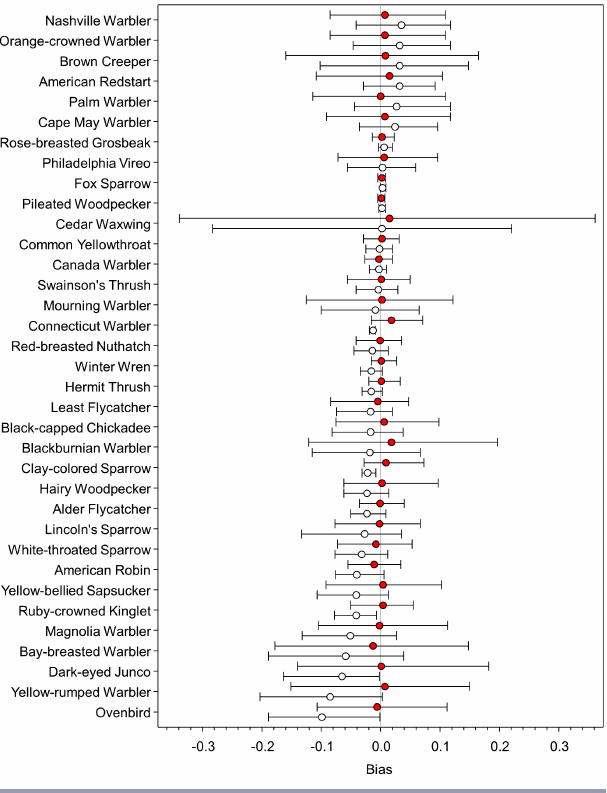
Fig. 4 . Bias in estimated densities (birds ha -1 ) from point count data derived from autonomous recording units (ARUs) compared to densities derived from human point counts conducted at the same time and location. Densities from human point counts were derived by adjusting counts for biases in availability ( p ) and perceptibility ( q ) using QPAD approach (Sólymos 2013) by inclusion in a statistical offset (i.e., log [EDR ² ∙ π ∙ p ], see Methods). Densities from ARU surveys H were derived by applying QPAD offsets from human observer data (open circles - log[EDR ² ∙ π ∙ p ]), versus adjusting the H offsets to account for the scaling constant δ (i.e., log[( δ * EDR )² ∙ π ∙ p ], closed red circles). Bias was estimated from H fitting models to 70% of the study sites and validated against the withheld external validation sites (30%) over 50 repeated random subsamples of the data. See Table 2 for scientific names of bird